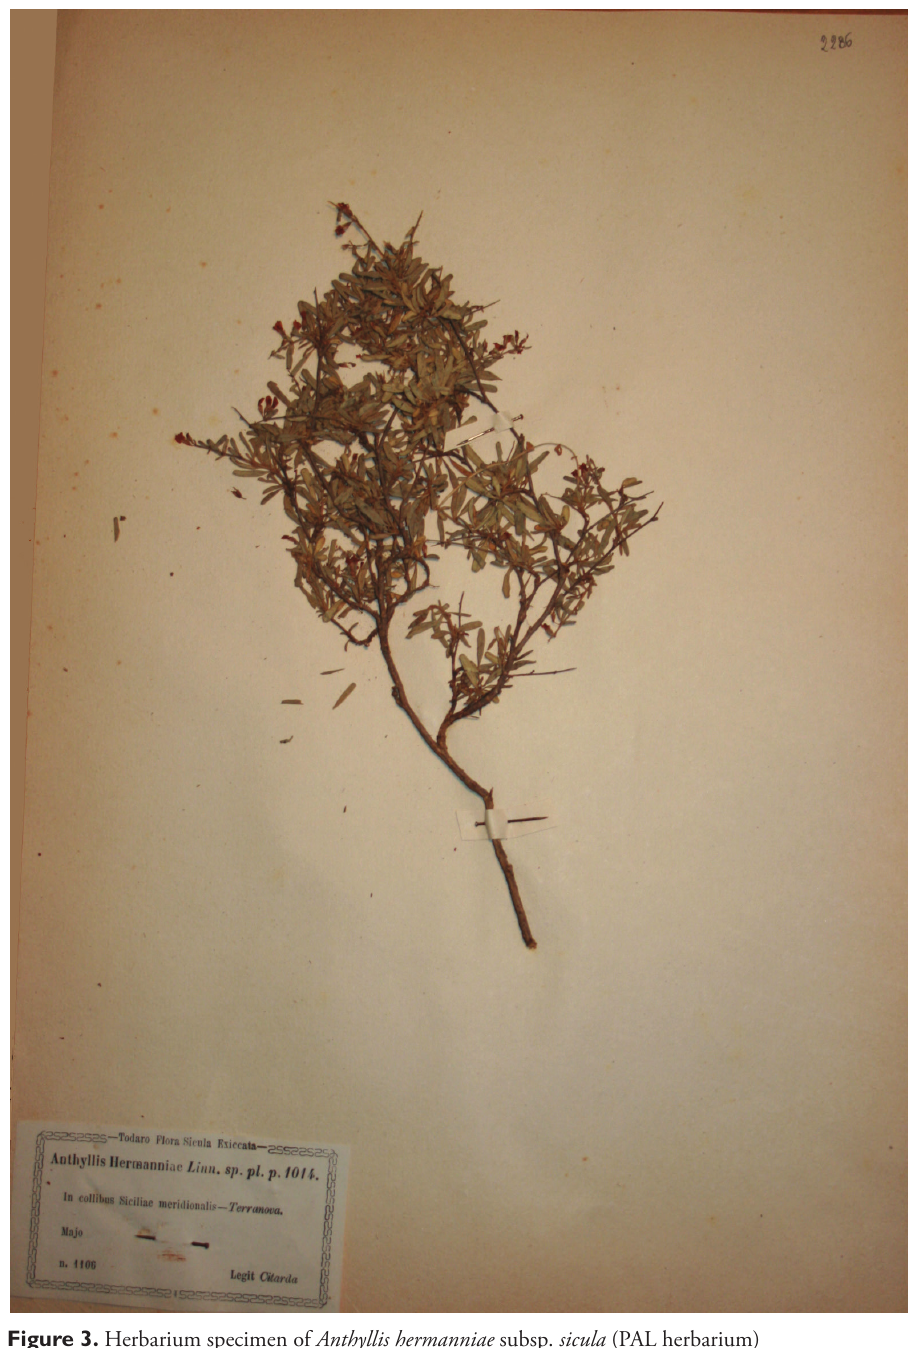
Figure 3. Herbarium specimen of Anthyllis hermanniae subsp. sicula (PAL